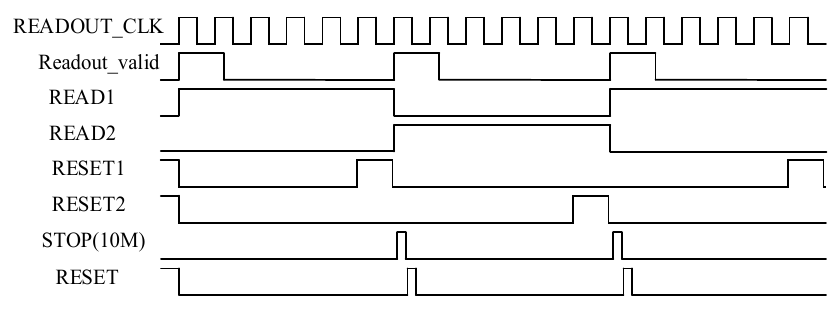
Figure 5. The timing diagram of the scheme.